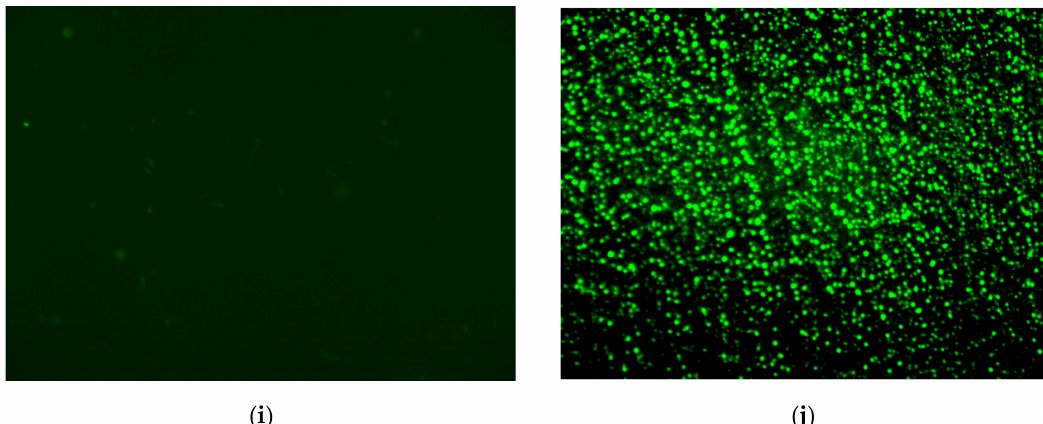
Figure 11. Microstructure evolution of modified asphalt under di ff erent aging degrees. ( a ) Virgin S4; ( b ) Virgin S4P3; ( c ) S4 aged for 1 h; ( b ) S4P3 aged for 1 h; ( e ) S4 aged for 3 h; ( f ) S4P3 aged for 3 h; ( g ) S4 aged for 5 h; ( h ) S4P3 aged for 5 h; ( i ) S4 aged for 7 h; ( j ) S4P3 aged for 7